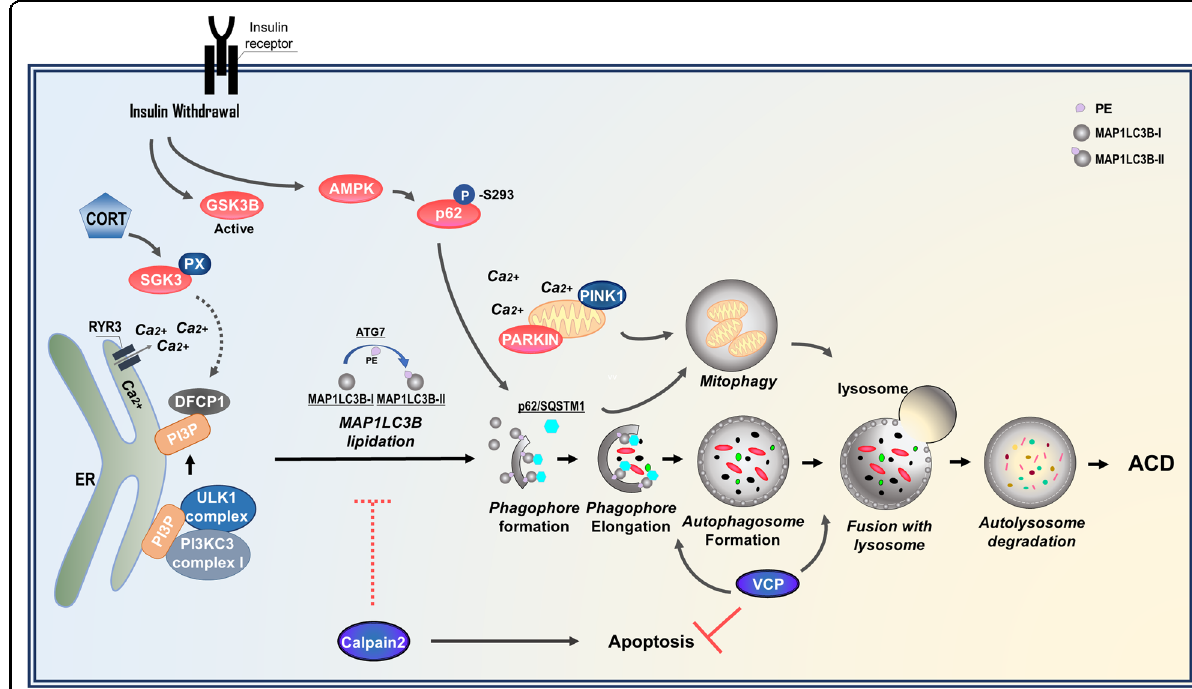
Fig. 2 Molecular effectors in ACD of adult hippocampal NSCs following insulin withdrawal or psychological stress. Insulin withdrawal activates GSK3B and AMPK, followed by AMPK-mediated phosphorylation of p62. RYR3 mediates the ef fl ux of Ca 2 + from the ER. PARKIN levels are upregulated in a GSK3B-dependent manner, and PARKIN is involved in the transfer of ER Ca 2 + to mitochondria and depolarization of mitochondrial membrane potential. Both p62 and PARKIN promote mitophagy, leading to ACD. Cell death triggered by insulin withdrawal is switched from ACD to apoptosis by calpain 2 and VCP. High levels of corticosterone (CORT) induced by CRS cause ACD via SGK3, which has a PX domain for binding to PI3P and the initiation of autophagy. The dashed lines indicate that the process is not yet experimentally con fi